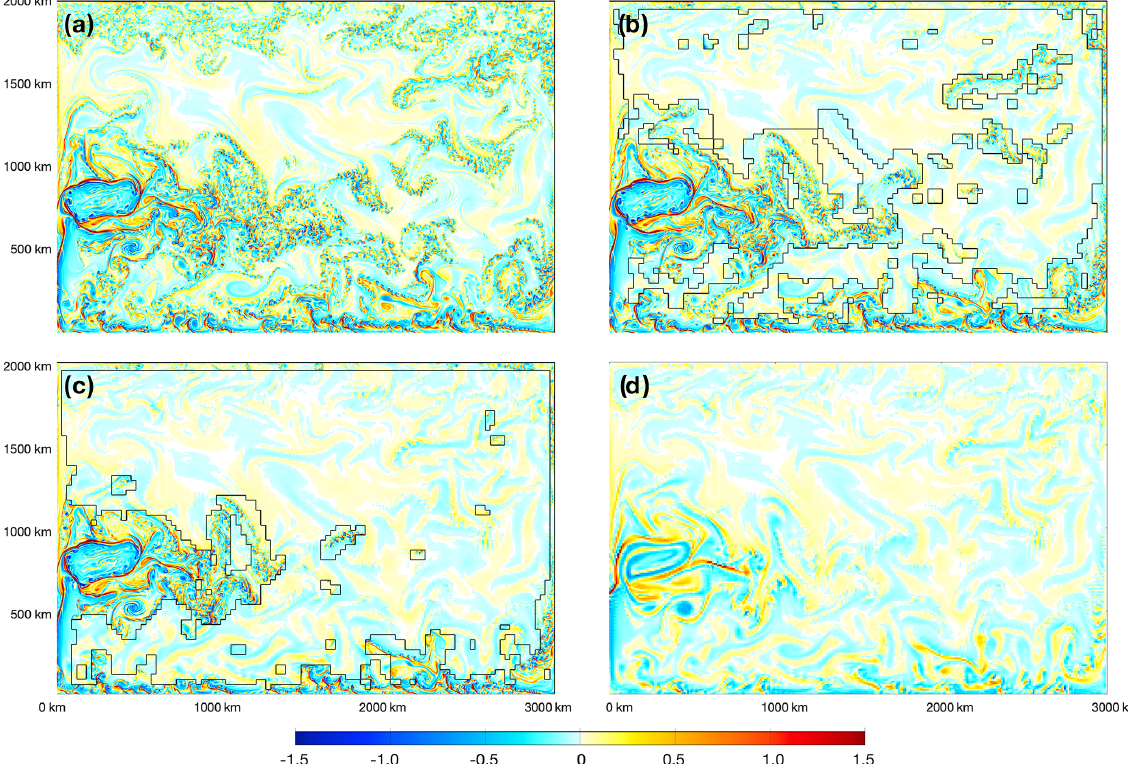
Figure 11. Same as Fig. 10 but for 20d after the refinement since 1